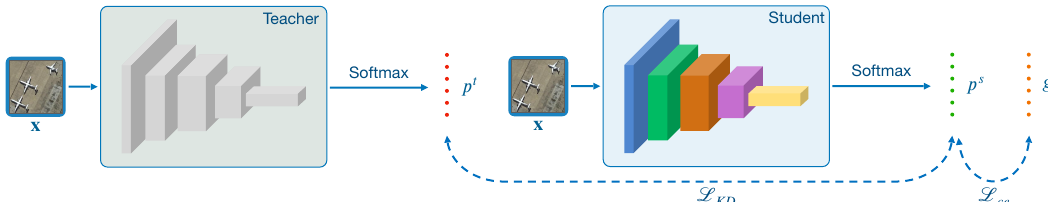
Figure 7. Illustrative diagram of our self-distillation procedure, which boost the performance of the self-supervised